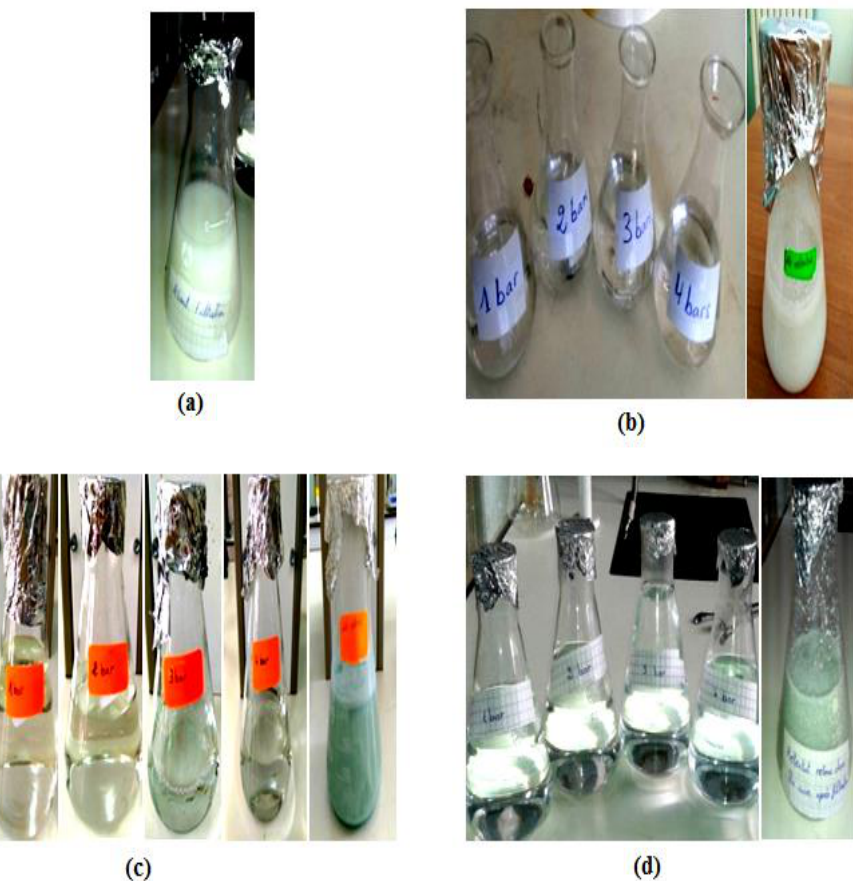
Figure 4. Representative image of the visual appearance of the effluent, ( a ) before filtration on the developed membranes, ( b ) after filtration on the developed membrane based on bentonite, ( c ) after filtration on the developed membrane based on Aomar clay, and ( d ) after filtration on the developed membrane based on kaolin.